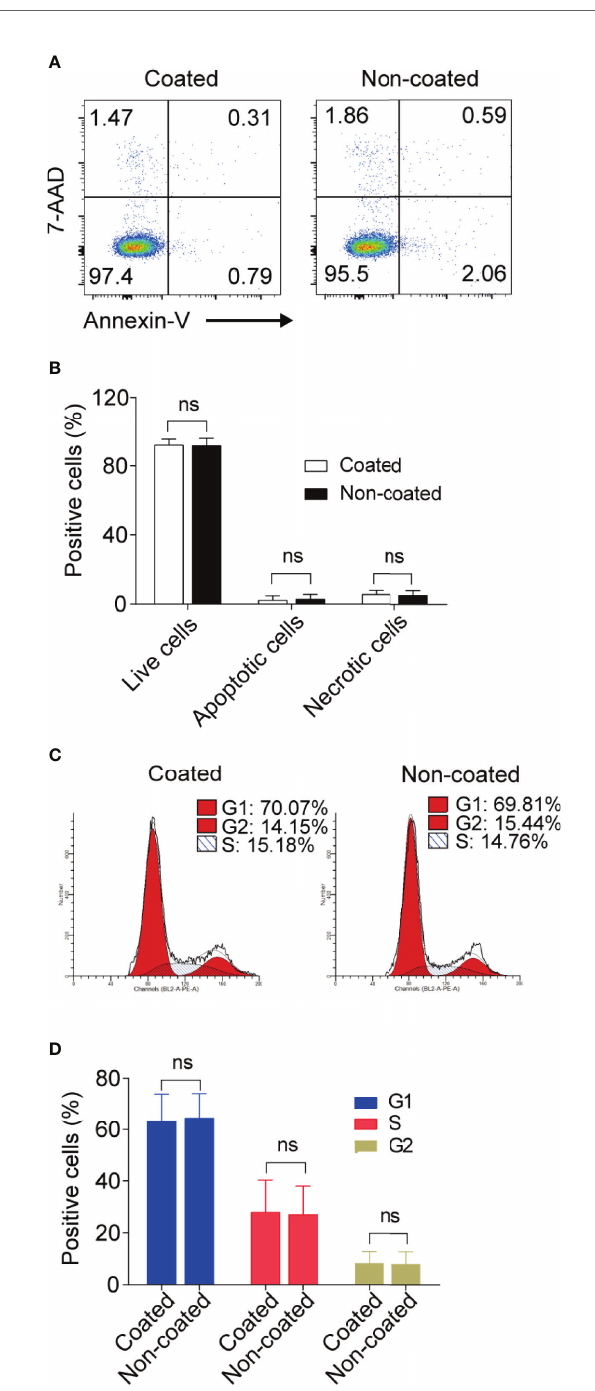
FIGURE 7 | Apoptosis and cell-cycle progression in NK cells induced by coated and non-coated rituximab did not differ. After expansion for 14 d, the NK cells were collected and assayed for apoptotic activity and cell cycle status. (A, C) Representative fl ow cytometry analysis of the percentage of apoptotic cells and the cell-cycle progression of cultured NK cells with coated or non-coated rituximab. (B, D) Statistical analyses of the percentages of apoptotic cells and the cell-cycle progression of NK cells cultured with coated or non-coated rituximab. n = 10 donors, ns, not signi fi cant p > 0.05; two-tailed paired